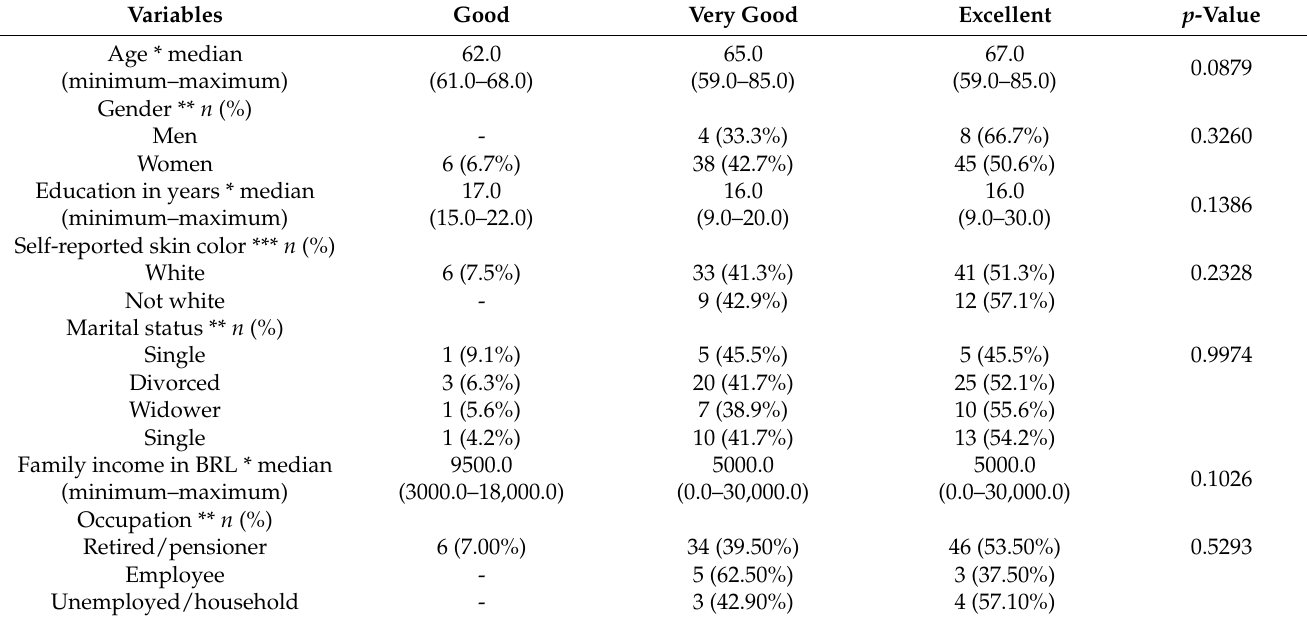
Table 3. Association of sociodemographic variables with the domains of self-care ability scale (SASCA) of elderly people enrolled at the Open University for Elderly People ( n =